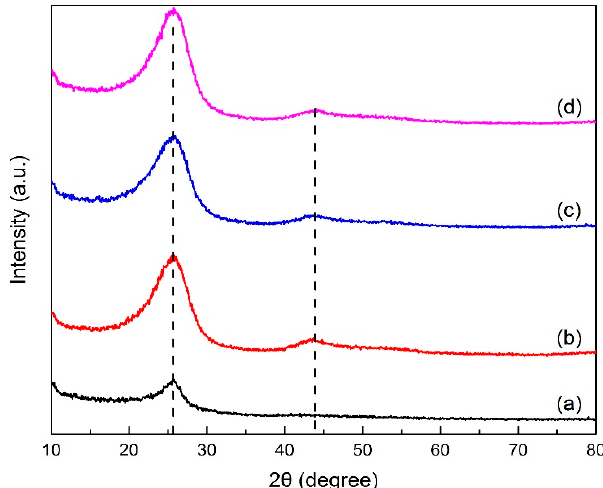
Figure 6. XRD patterns of (a) green petroleum coke, (b) N-GLPs 750 2 , (c) N-GLPs 750 4 , and (d) N-GLPs